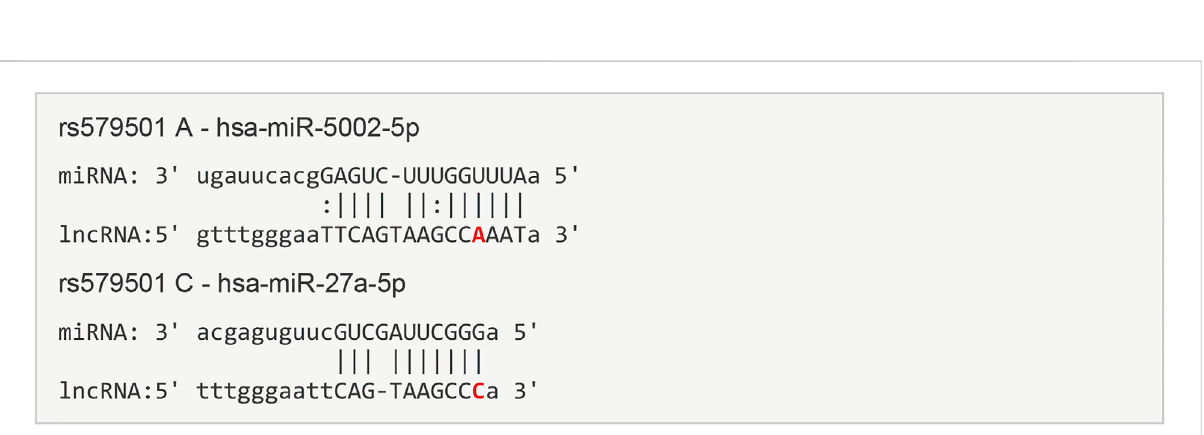
FIGURE 2 Prediction target microRNAs of lnc-ZNF33B-2:1 polymorphism. The sequence and putative binding sites of miR-5002-5p and miR-27a-5p on the different re579501 allele were validated using the lncRNA-binding prediction software